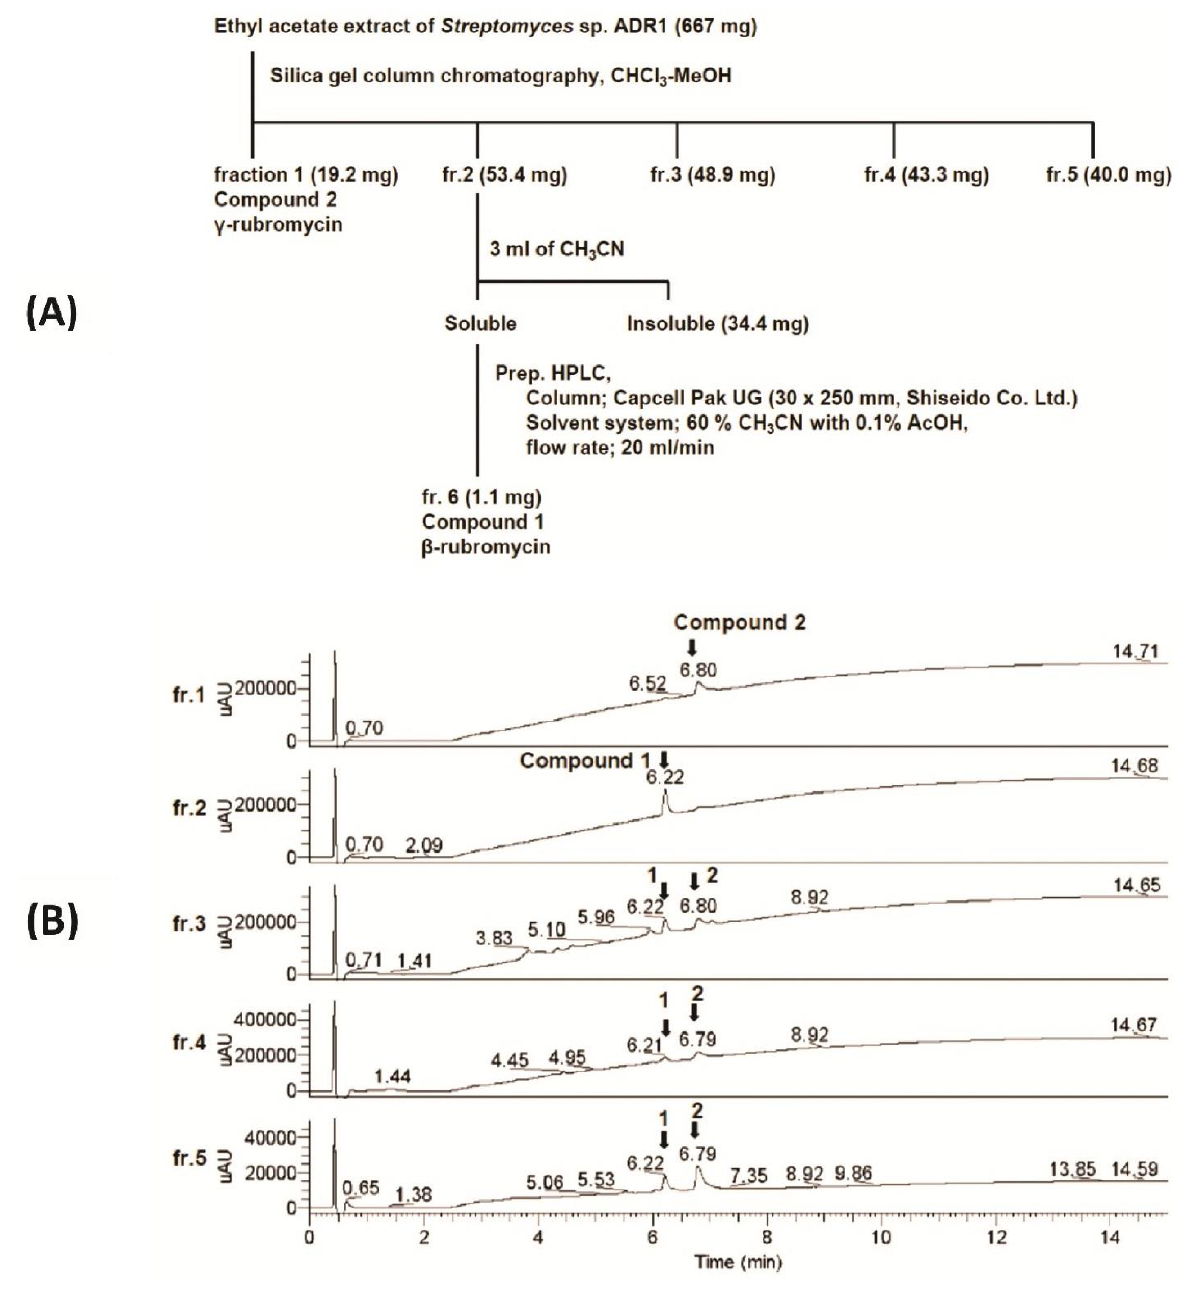
Figure 4. ( A ) Work-up procedure of extraction and purification of β - and γ -rubromycin from Streptomyces sp. ADR1; ( B ) fraction purification by reversed-phase HPLC.